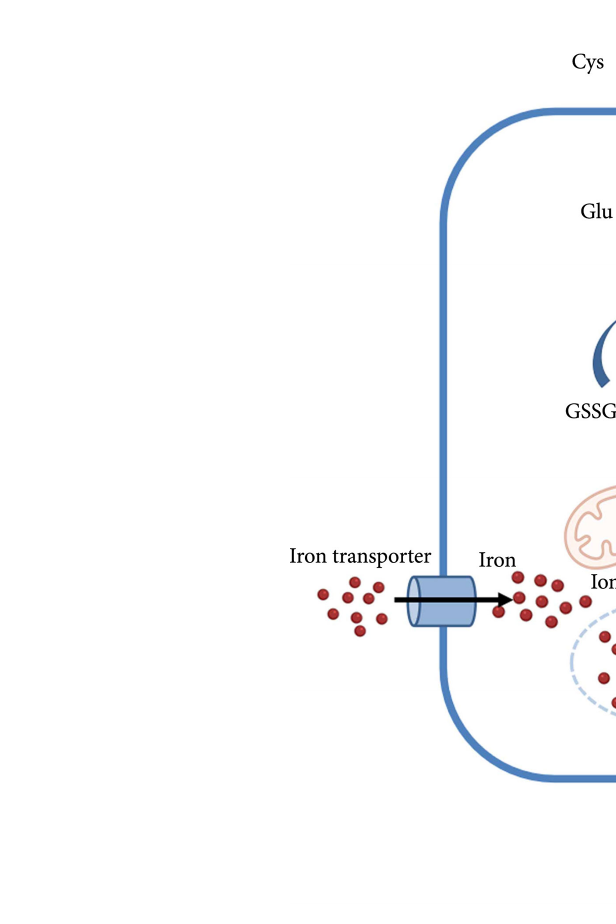
FIGURE 2 Molecular mechanism of